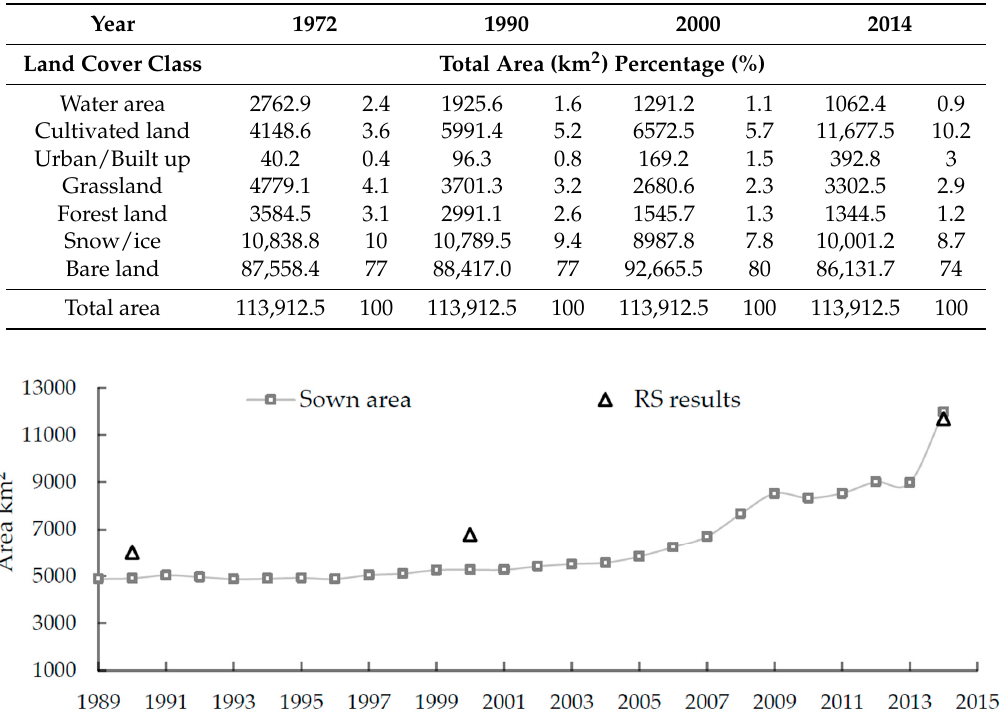
Figure 5. Sown area and remotely sensed (RS) estimated cultivated area comparison for Kashgar Region (sown area source [22]).